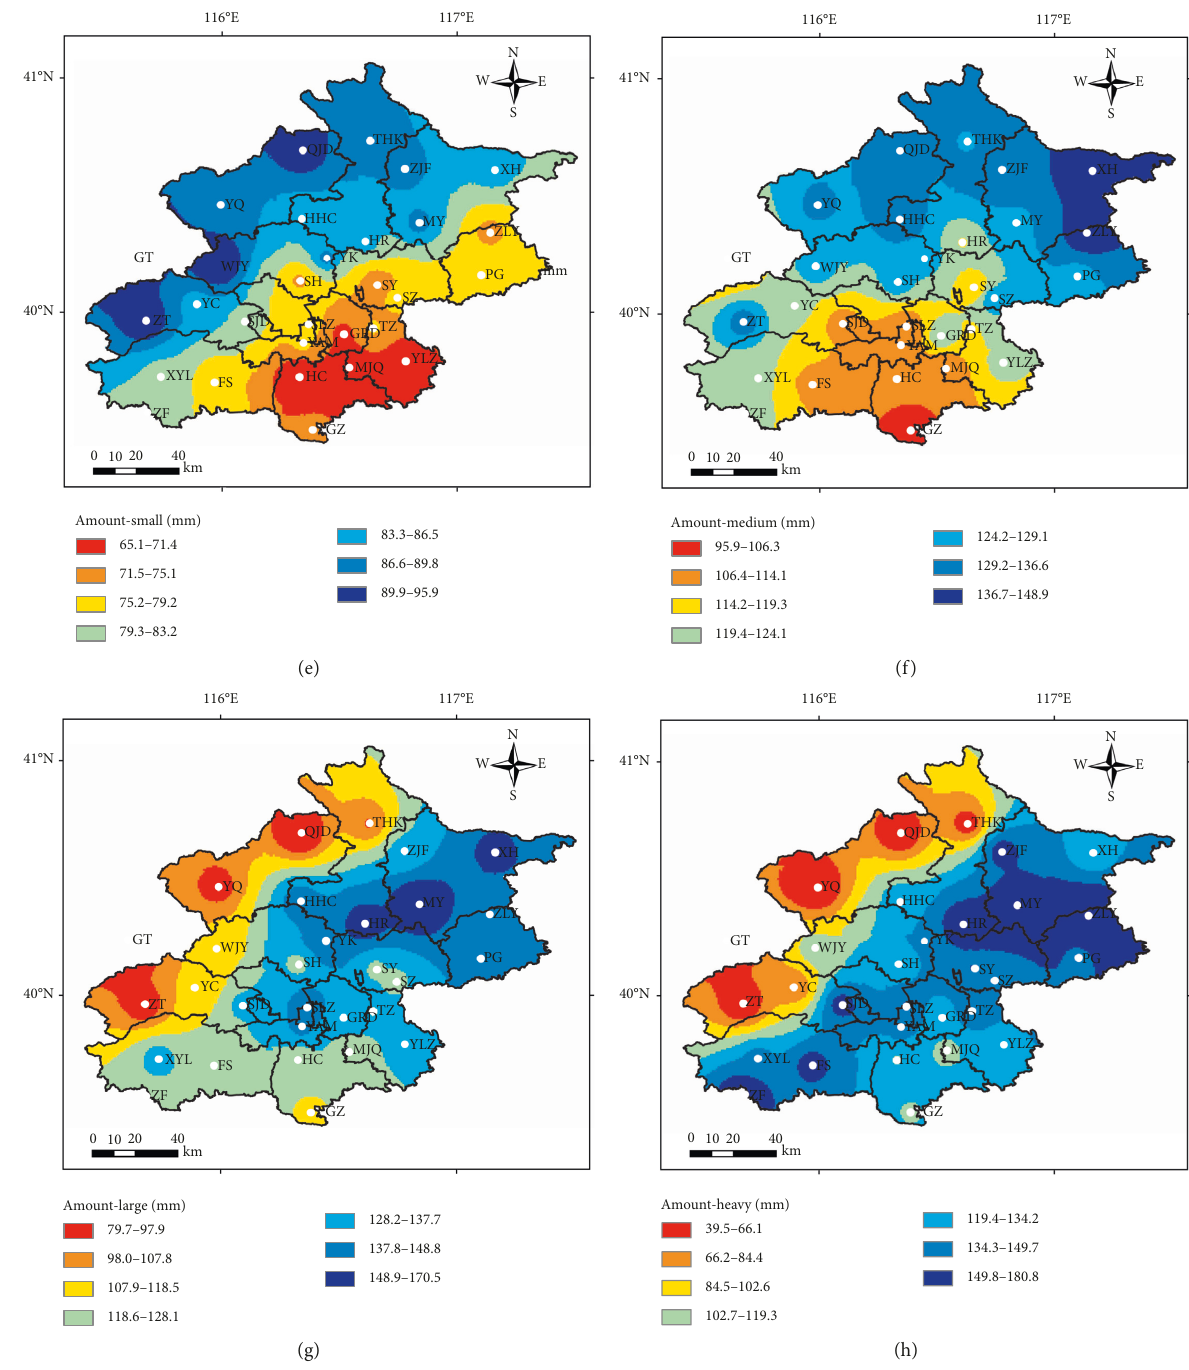
Figure 9: Spatial distribution of precipitation frequency and amount for the different grades during 1960–2012. (a, e) Small precipitation. (b, f) Medium precipitation. (c, g) Large precipitation. (d, h) Heavy